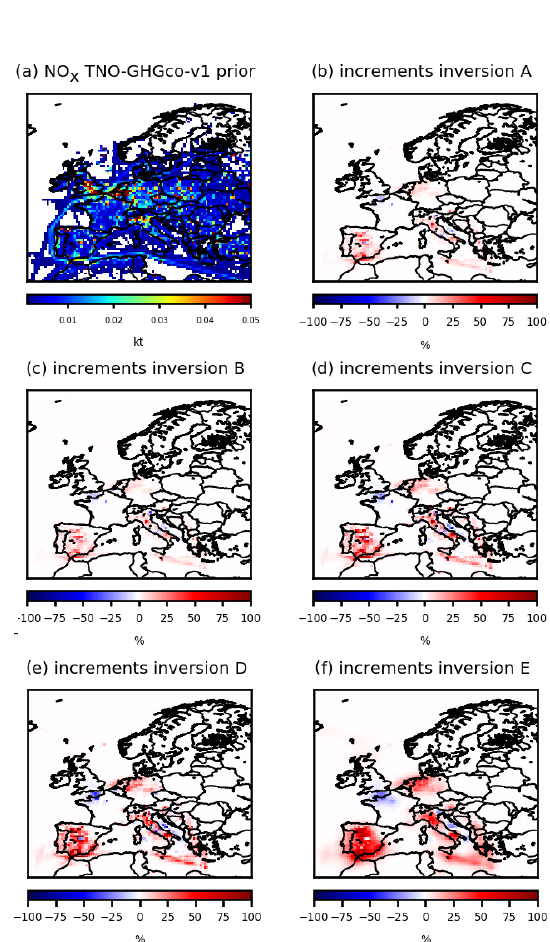
Figure 8. (a) TNO-GHGco-v1 NO x anthropogenic prior emissions, in ktNO 2 per grid cell and increments provided by the inversion (b) A, (c) B, (d) C, (e) D and (f) E with constraints from OMI 19 February 2015, in %. The description of the different inversions is given in Table